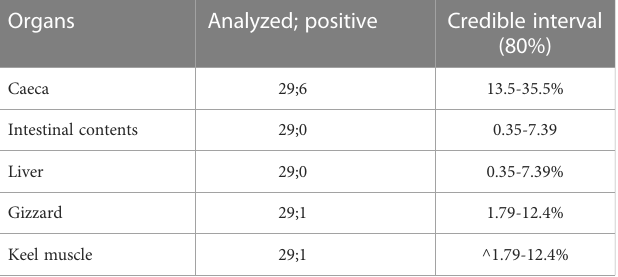
The fi rst number in parentheses corresponds to the total number of swabbed banded birds or ceca, the second number corresponds to the number of positive cases among all banded birds swabbed during the given period, or among all the ceca analyzed. A cross indicates cases where not enough data (N<10) were available to allow for an